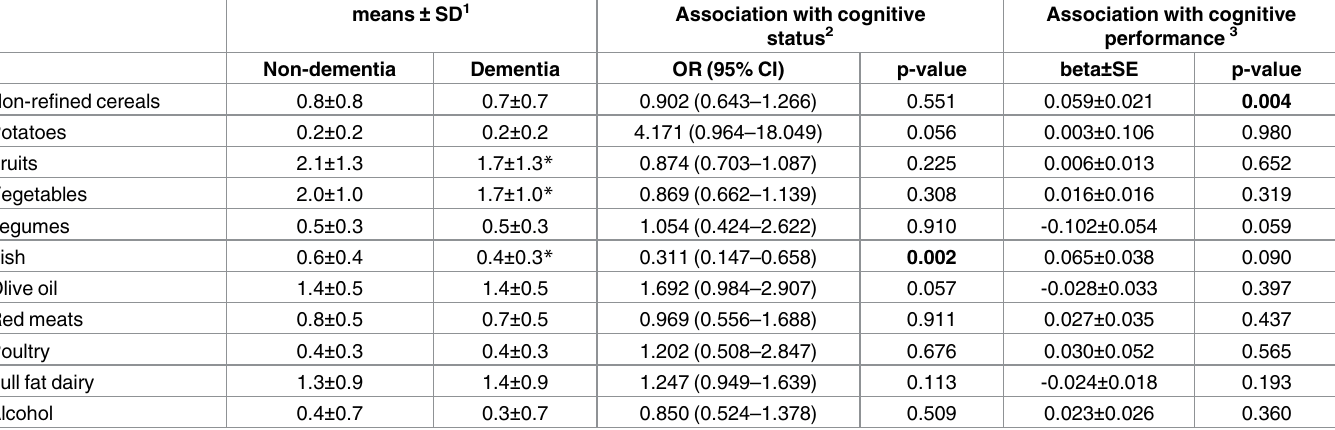
Table 5. Individual components of the Mediterranean dietary pattern by cognitive status and their association with cognitive status and cognitive